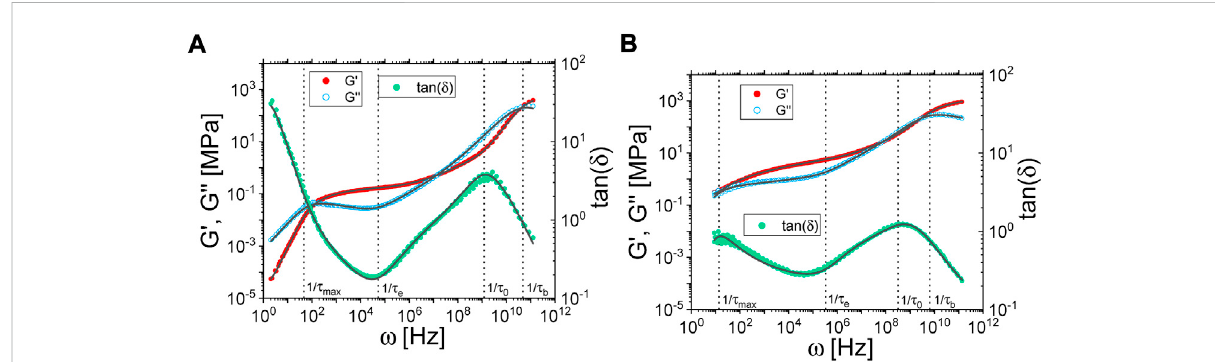
FIGURE 1 (A) and (B) master curves obtained after the horizontal shifting procedure at a reference temperature of 413 K for the neat polymer matrix and the 40 phr Coupsil composite samples respectively. Filled symbols are for the storage modulus G ′ and empty symbols are for the loss modulus G ’‘ . Symbols areexperimental data andsolidlines arethe fi t. G ′ , G ″ and tan ( δ ) are fi ttedsimultaneously. Verticallines show the characteristicfrequencies thus